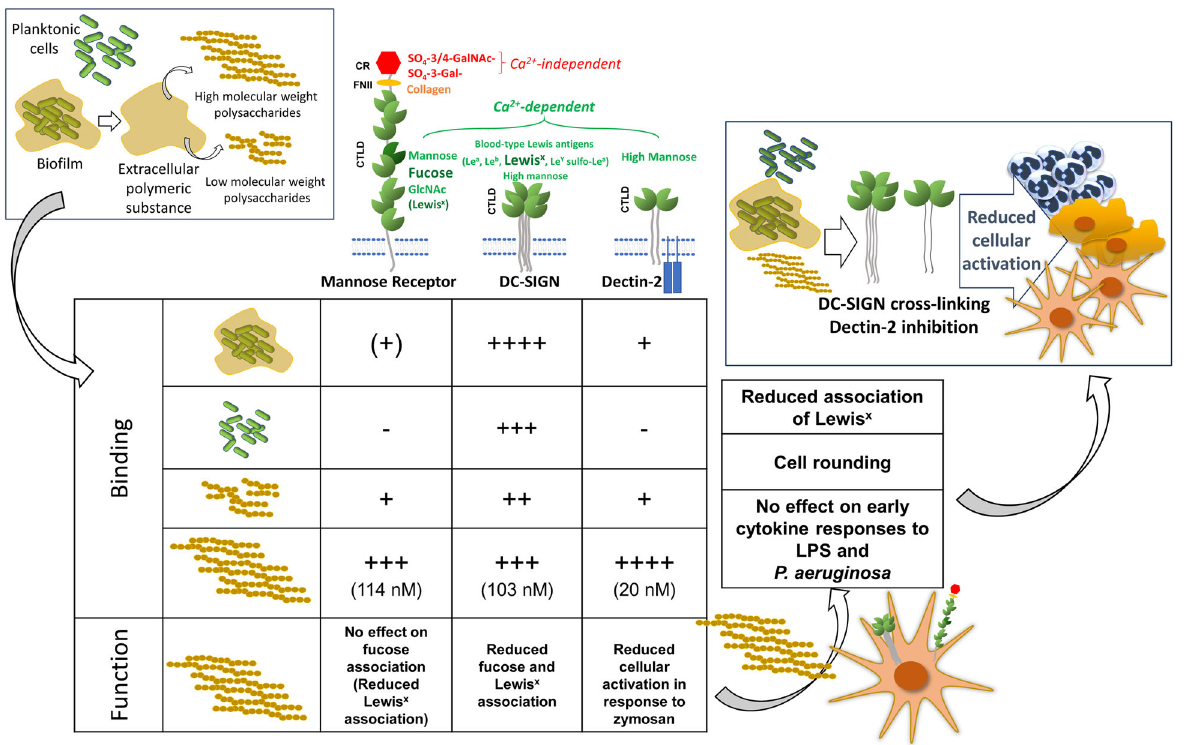
Fig. 7 Involvement of C-type lectin receptors in the recognition of P. aeruginosa. P. aeruginosa bio fi lms, planktonic cells and high and low molecular weight bio fi lm carbohydrates were tested for their interaction with three important C-type lectins: DC-SIGN, MR and Dectin-2. DC- SIGN seems to play a dominant role in P. aeruginosa recognition based on its ability to bind bio fi lms, planktonic cells and puri fi ed bio fi lm carbohydrates, while Dectin-2 and MR preferentially bind puri fi ed bio fi lm carbohydrates. Functionally, puri fi ed bio fi lm carbohydrates interfere with DC-SIGN, Dectin-2 and, partially, MR activities and in fl uence the phenotype of immune cells (moDCs). These fi ndings implicate C-type lectins, particularly DC-SIGN, and to some extent Dectin-2, in the detection of P. aeruginosa infection and support a potential role for bio fi lm carbohydrates in modulating immunity to P. aeruginosa. DC-SIGN engagement and Dectin-2 blocking in a variety of innate immune cells such as DCs, macrophages and neutrophils could lead to immune evasion by reducing cellular